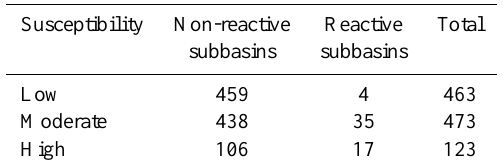
With this method, similar weights have been obtained for (cid:49)h max and s mean (0.40 and 0.35, respectively; right column